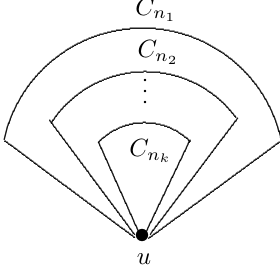
Figure 8: A planar embedding ˜ D ( S ) of D ( S ) in Case